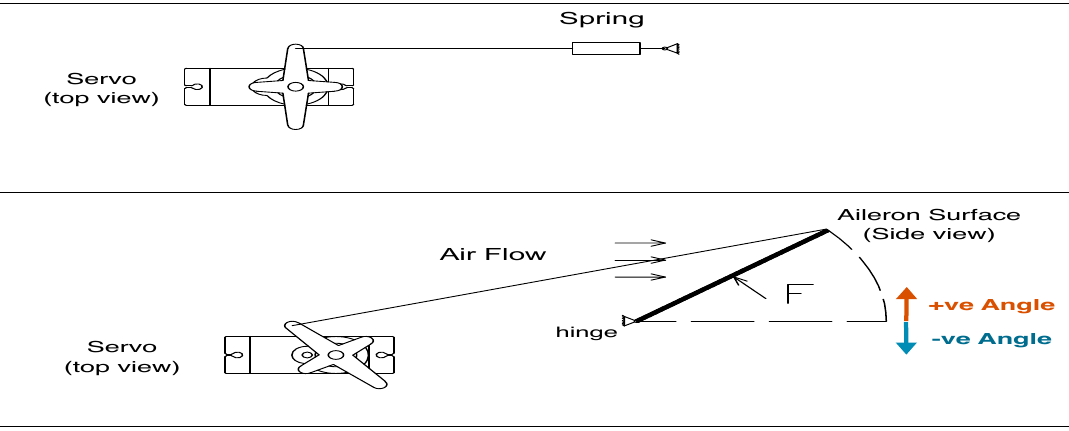
Figure 1. Servo/Control-Surface System